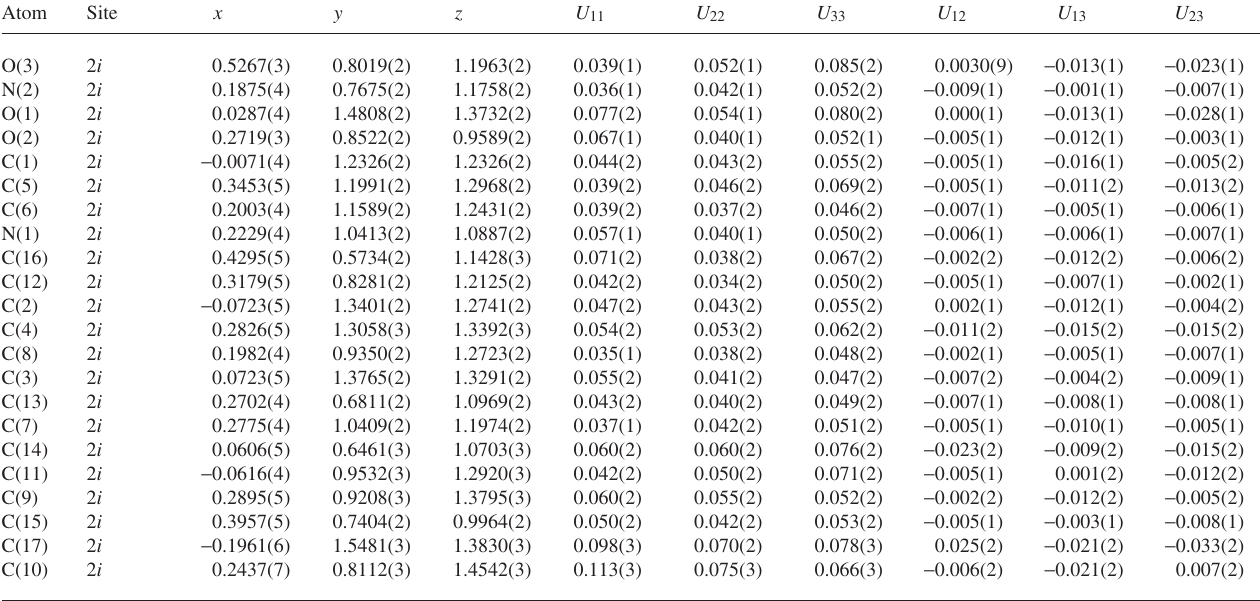
Table 3. Atomic coordinates and displacement parameters (in Å 2 ) .